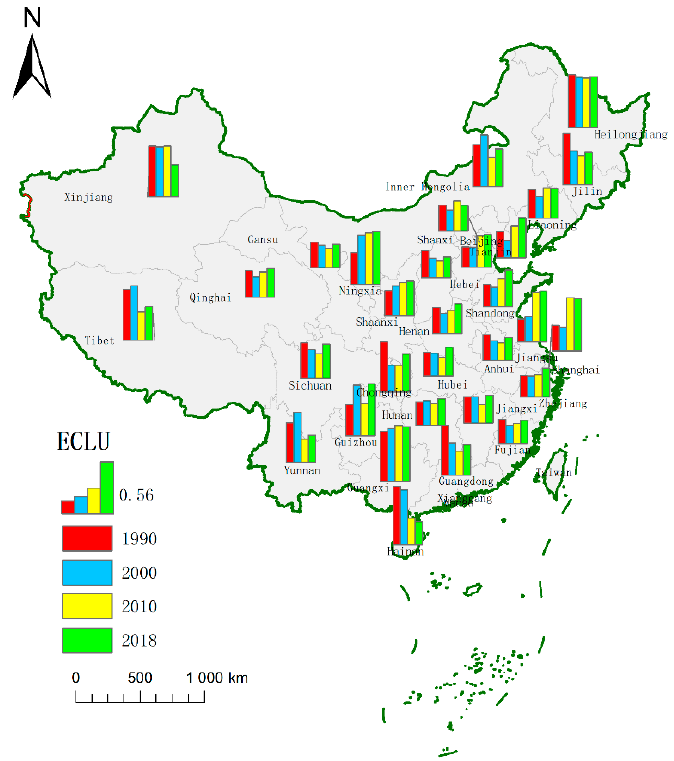
Figure 4. The spatial evolution of the